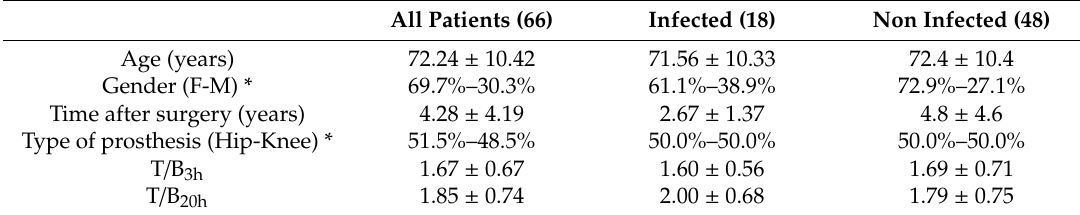
Table 1. Characteristics of study population.